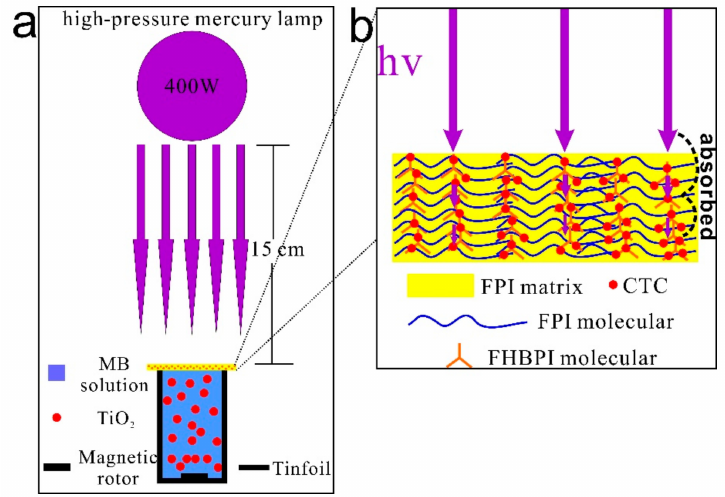
Figure 7. ( a ) Simulation illustration for UV-shielding measurement of FPI / FHBPI composites under intense ultraviolet lights; ( b ) Schematic illustration for UV-shielding of FPI / FHBPI